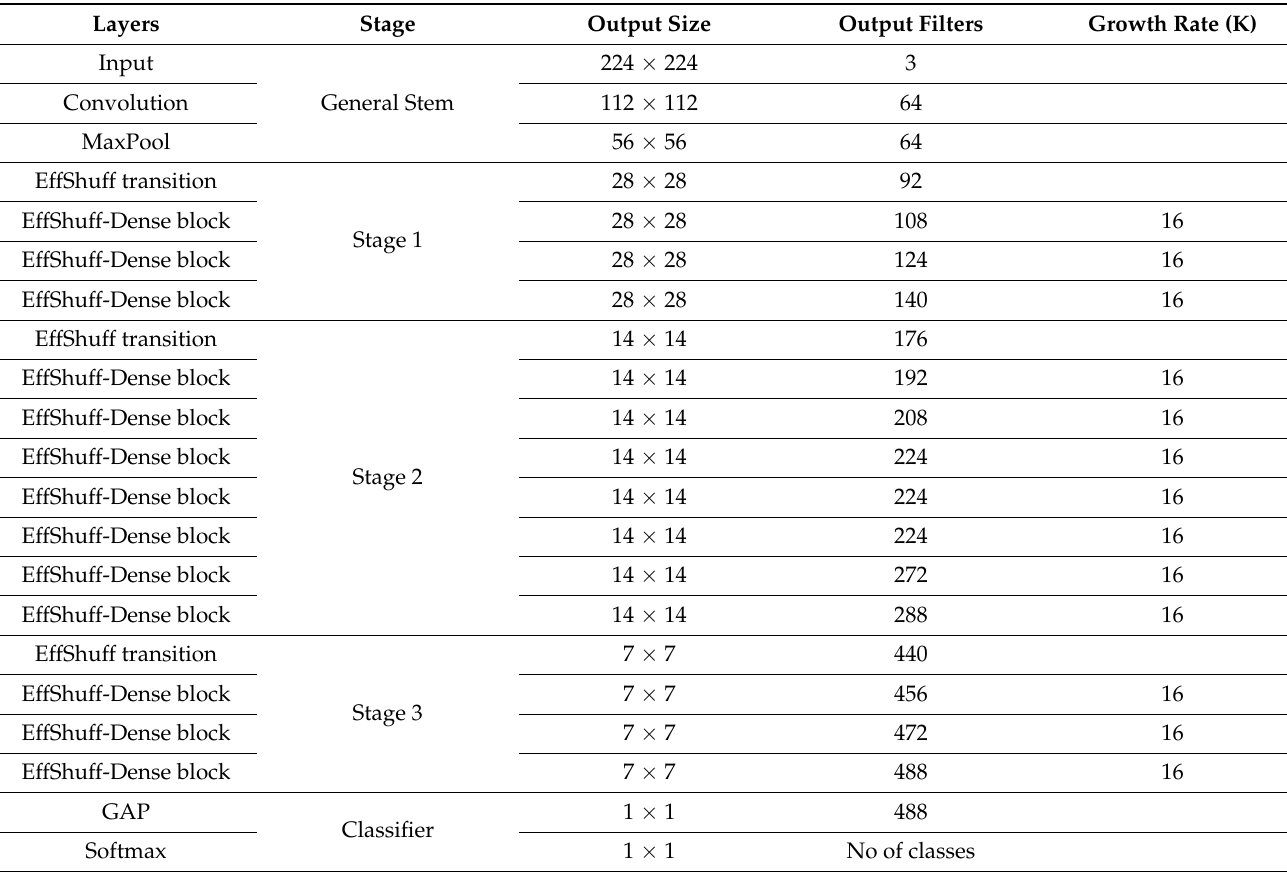
Table 2. EffShuff-Dense-Block model